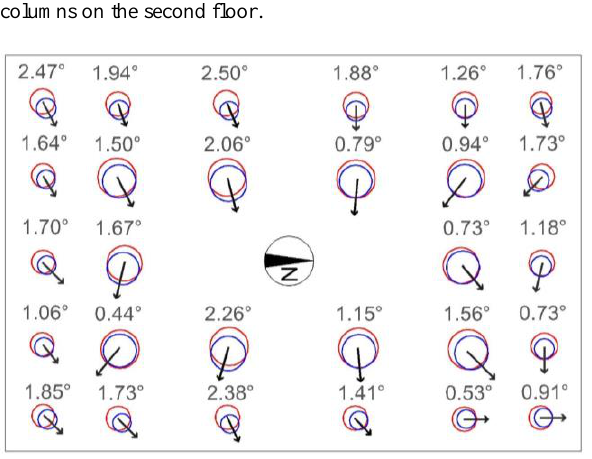
Figure 9. Statistical graph of the columns on the second